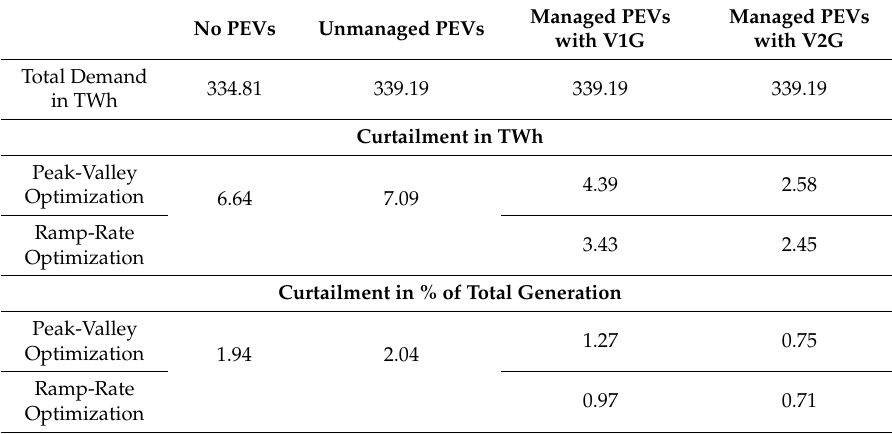
Table 16. Curtailment Figures for California—Mid Scenario 2030—3.3 Million ZEVs.